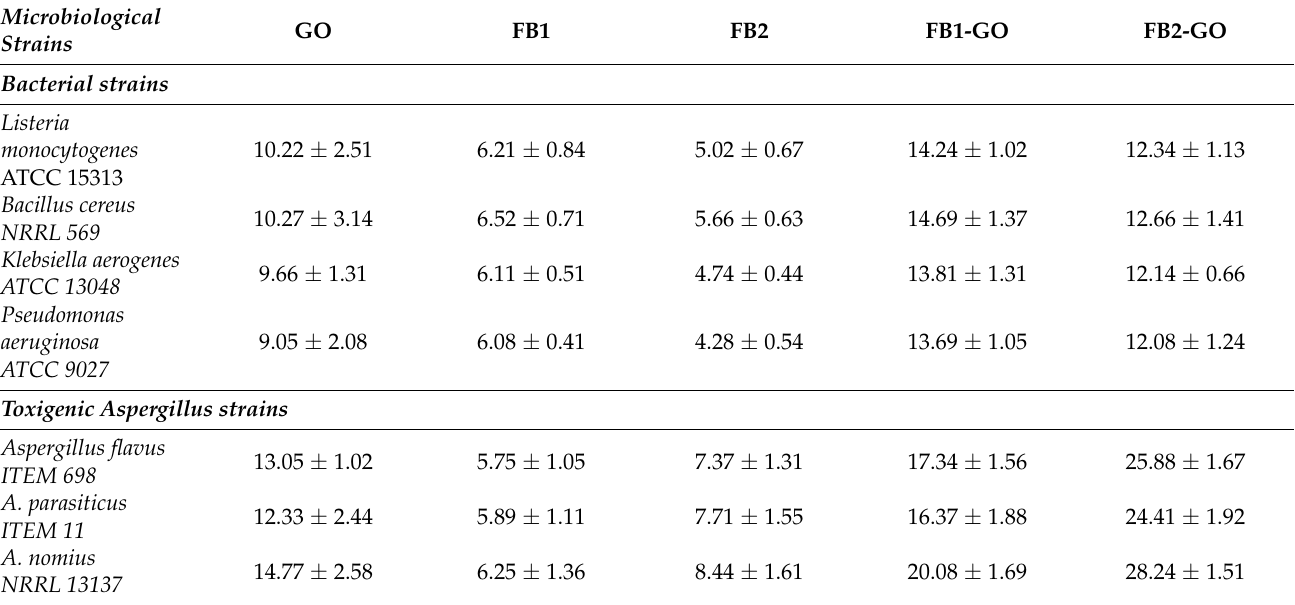
Table 3. The antibacterial and anti-aflatoxigenic properties of the nanoemulsion composites contain- ing ginger oil.